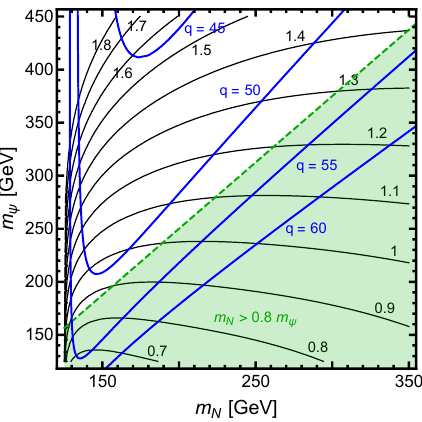
Figure 2 . The e(cid:11)ective coupling (cid:24) = (cid:18) S y S required to obtain the observed relic density in Scenario 1B. Direct-detection limits from LUX 2016 are shown in